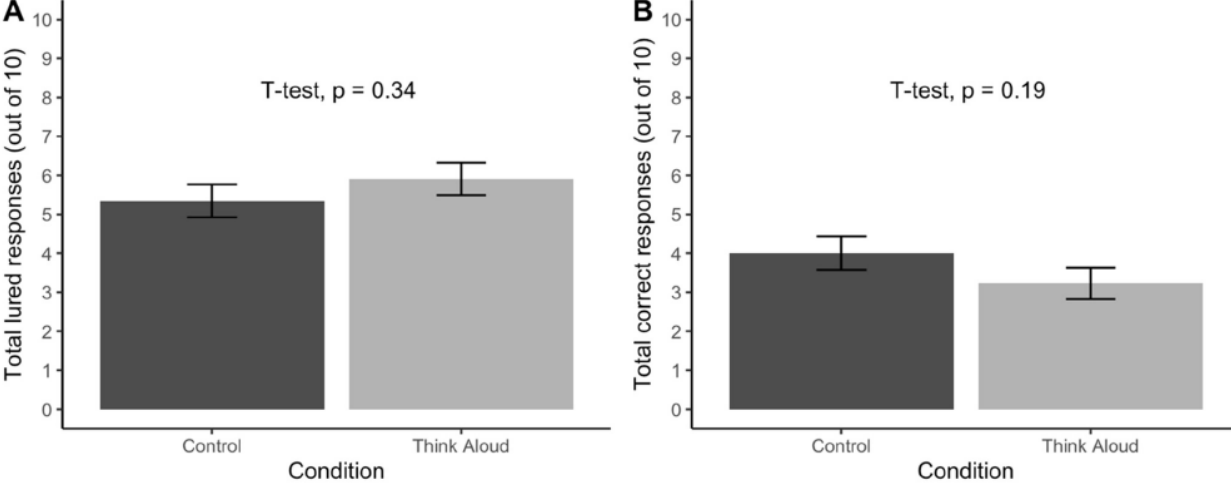
Figure 1. The effect of thinking aloud on ( A ) the number of lured responses and ( B ) the number of correct responses on the verbal cognitive reflection test (vCRT) in Study 1 (N = 99). Error bars represent a standard